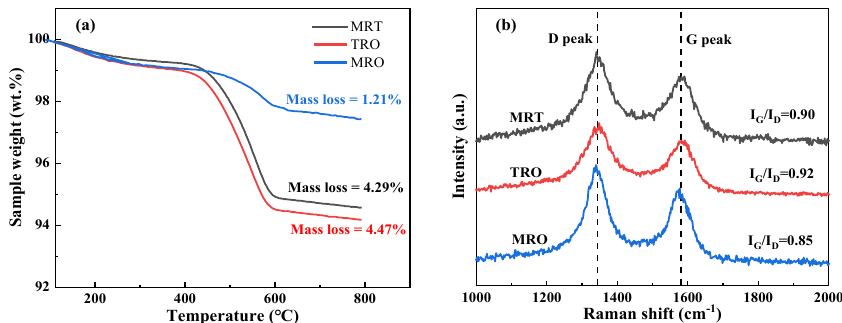
Figure 3. ( a ) TGA analyses and ( b ) Raman spectra of spent